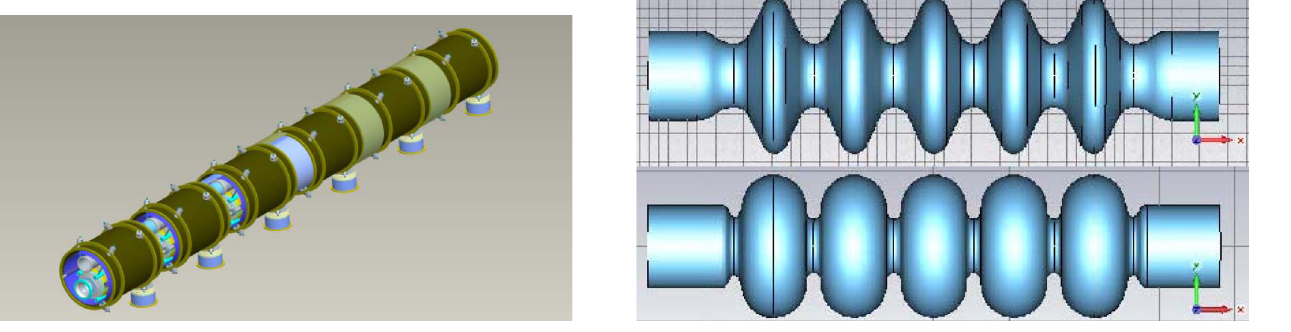
FIG. 11. The models for the BNL1 (top) and BNL3 (bottom) cavities.FIG. 10. An energy recovery linac cryomodule with six